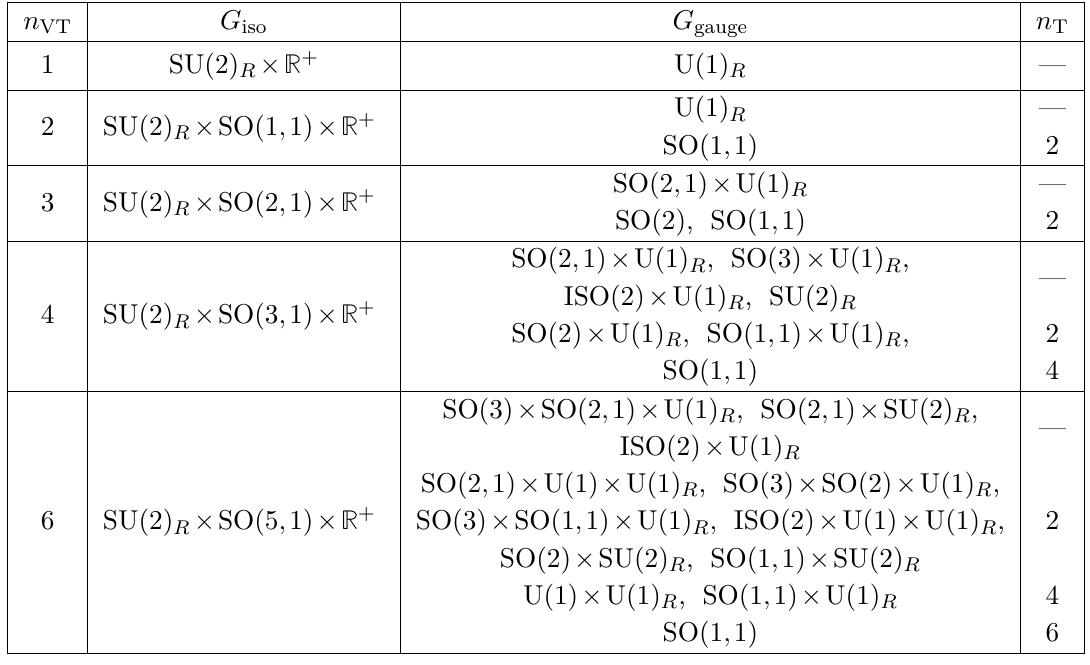
Table 2 . Allowed gaugings G gauge of the global isometry groups G iso in the generic cases with n VT vector/tensor multiplets. The first column gives the total number of vectors and tensor multiplets, the second the global isometry group, the third the allowed gaugings and the last one the number of vectors that are dualised to tensors in each